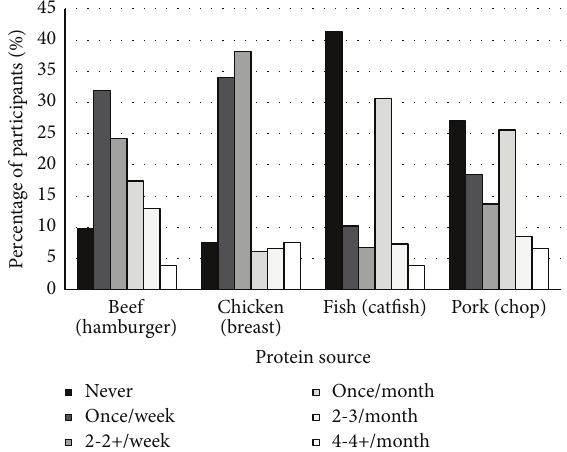
Figure 4: Consumption rate and frequency of the most consumed foods for each protein source by pregnant women.